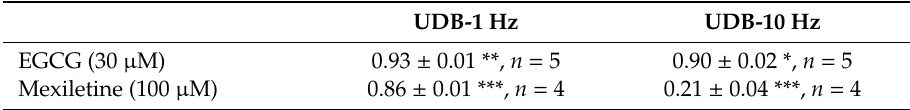
Figure 4. Use-dependent block protocol in the presence or absence of 30 µ M EGCG. ( a ) Representative trace of I Na currents at 1 and 10 Hz in the presence of 30 µ M of EGCG. ( b ) Normalized I Na current versus pulse number in the presence or absence of 30 µ M of EGCG at 1 and 10 Hz. ( c ) Representative trace of I Na currents at 1 and 10 Hz in the presence of 100 µ M of Mexiletine. ( d ) Normalized I Na current versus pulse number in the presence or absence of 100 µ M of mexiletine at 1 and 10 Hz. Table 2. Characterization of the use-dependent block of EGCG .